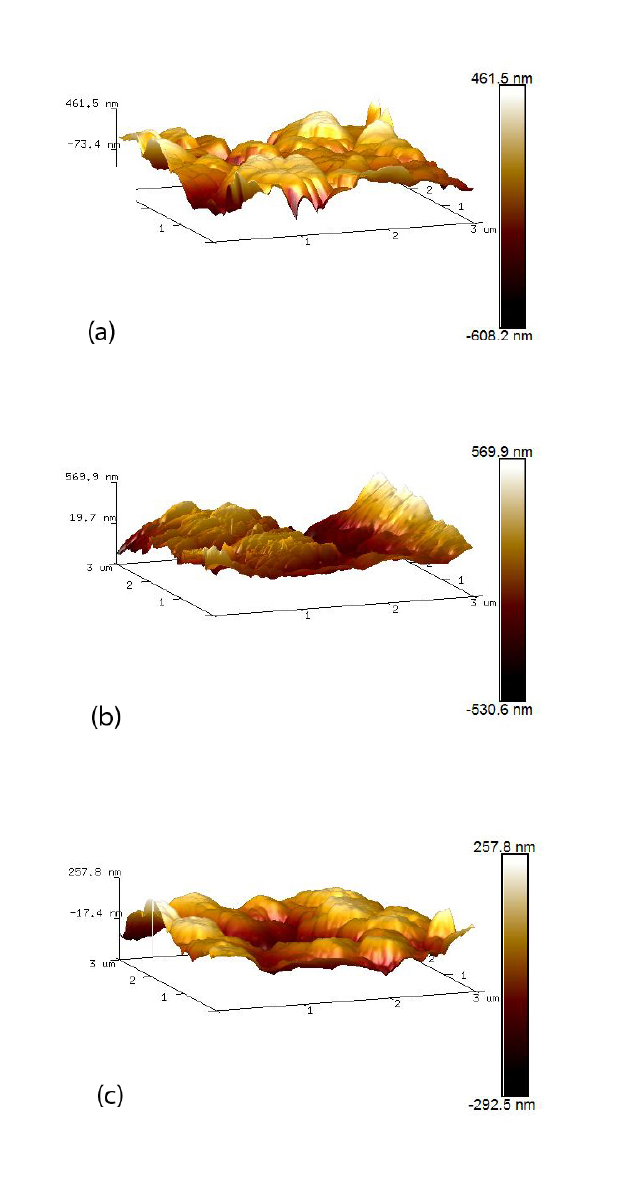
Figure 3. AFM 3D images of 3 µ m by 3 µ m area of the nano-surfaces: ( a ) 1% pure ZnO; ( b ) 1% pure CuO; ( c ) 1% ZnO and CuO suspensions with the ratio of 1:2. Table 1. Image surface area comparisons of nano-surfaces analysed by NanoScope Analysis